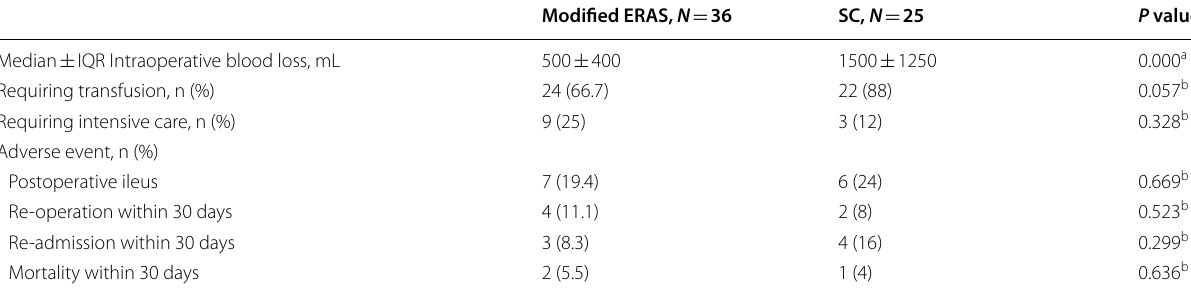
ERAS Enhanced Recovery After Surgery, SC standard care, IQR interquartile range a Using Shapiro–Wilk and Mann–Whitney U test analysis b Using Chi-square test